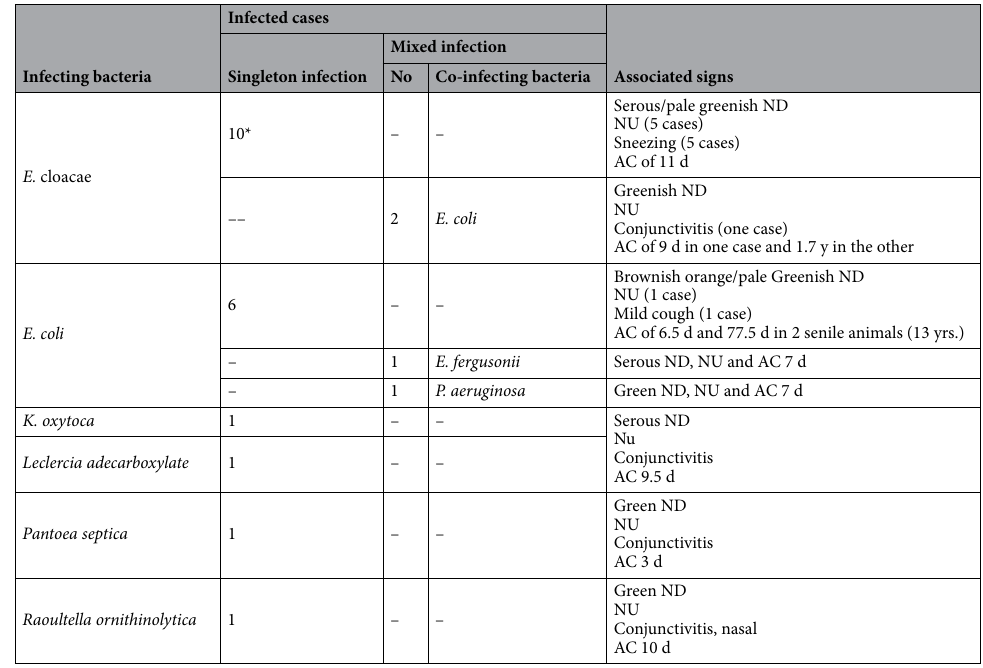
Table 1. Symptoms present in diseased cats. ND nasal discharge, NU nasal ulcer, AC average course. *Two cases were infected by multiple strains of E. cloacae with different phenotypic and genotypic resistance patterns (one case infected by 3 strains recovered from different sources and the second case infected with two